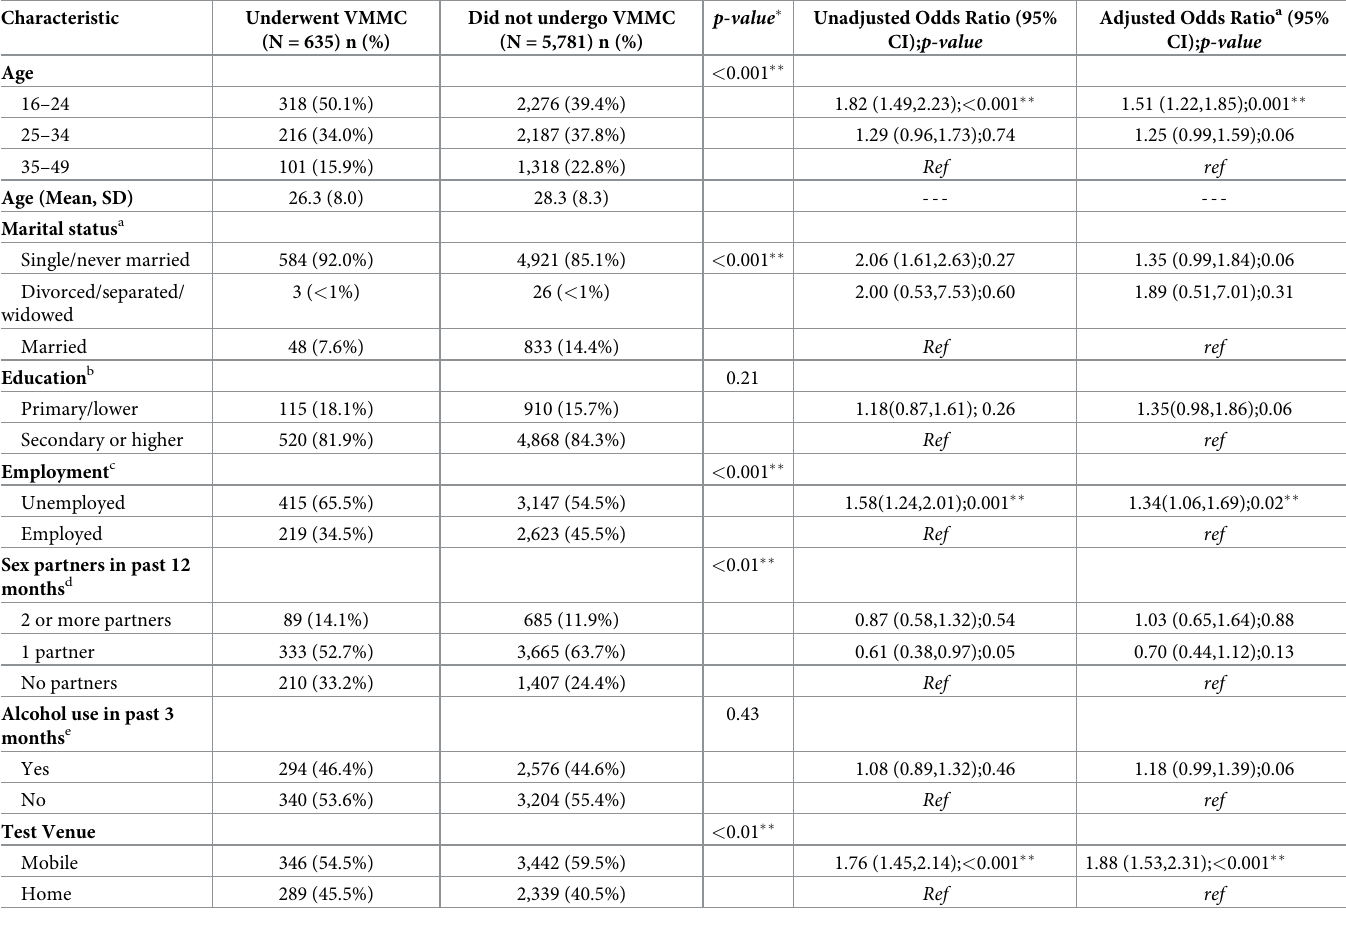
Table 2. Demographics and risk factors of initially uncircumcised men who did vs. did not undergo VMMC during the study, N = 6,416.